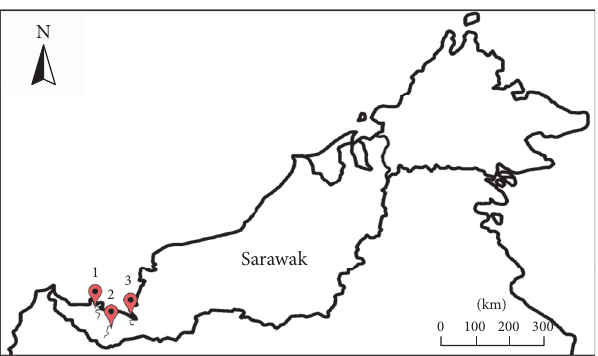
Figure 1: Sampling area in western part of Sarawak: 1: Samarahan River, 2: Bunga-Baki River, and 3: Kepayang